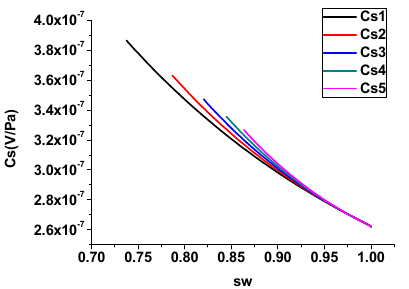
Figure 7. Influence of bubble spacing on streaming potential coupling coefficient (bubbly flow).